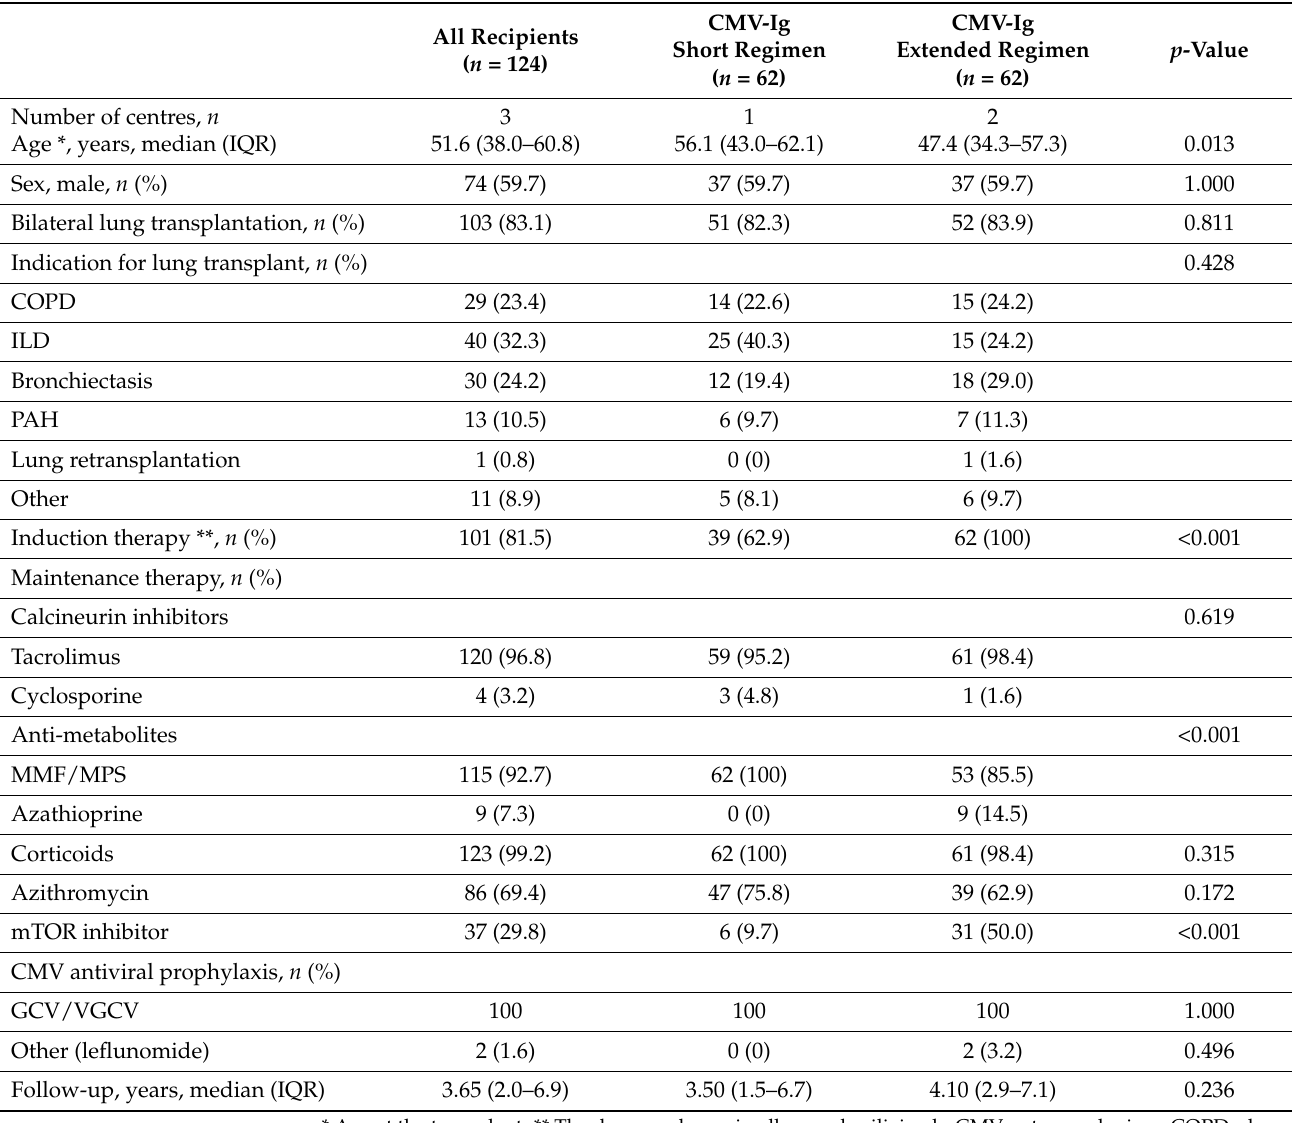
Table 1. Baseline demographic and clinical characteristics, immunosuppressive strategies, and CMV-prophylaxis of the recipients included in the study by adjunctive CMV-Ig schedule